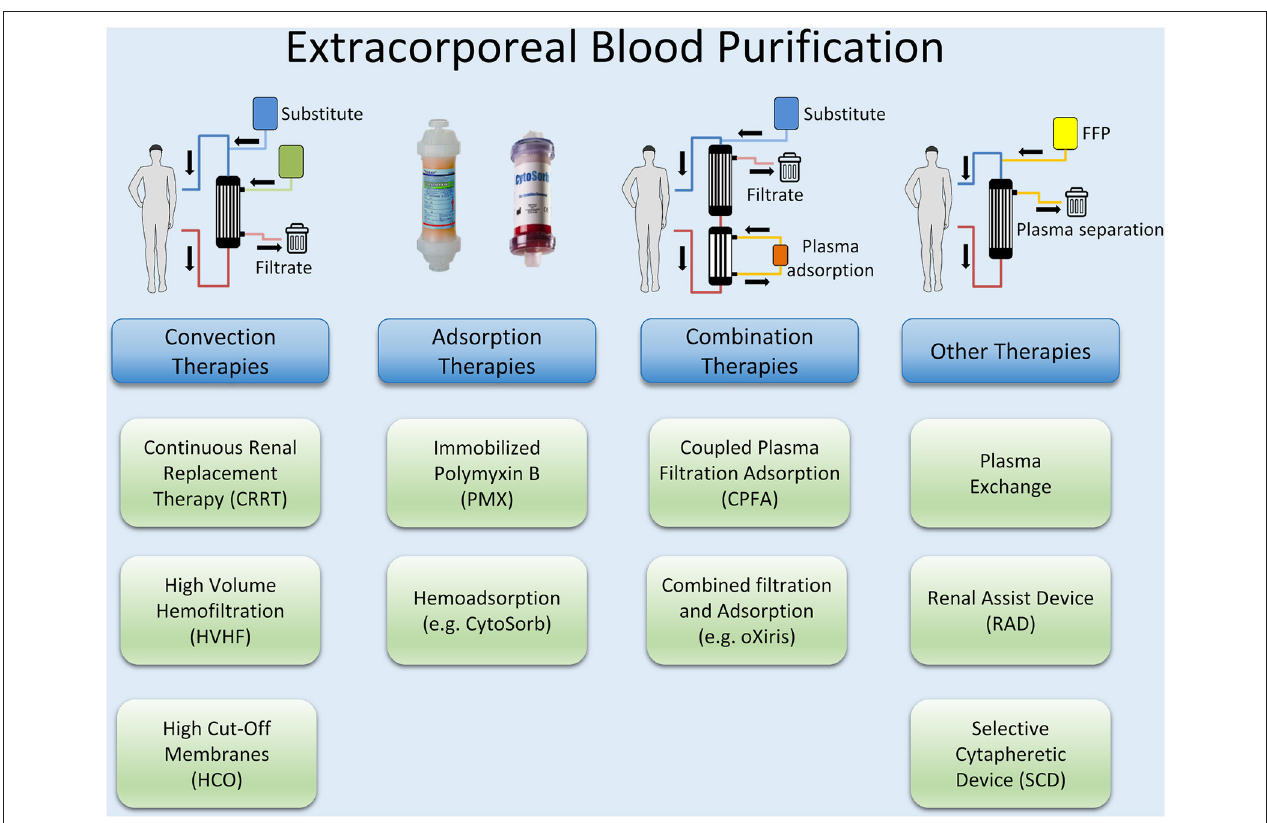
FIGURE 3 | Currently available blood purification